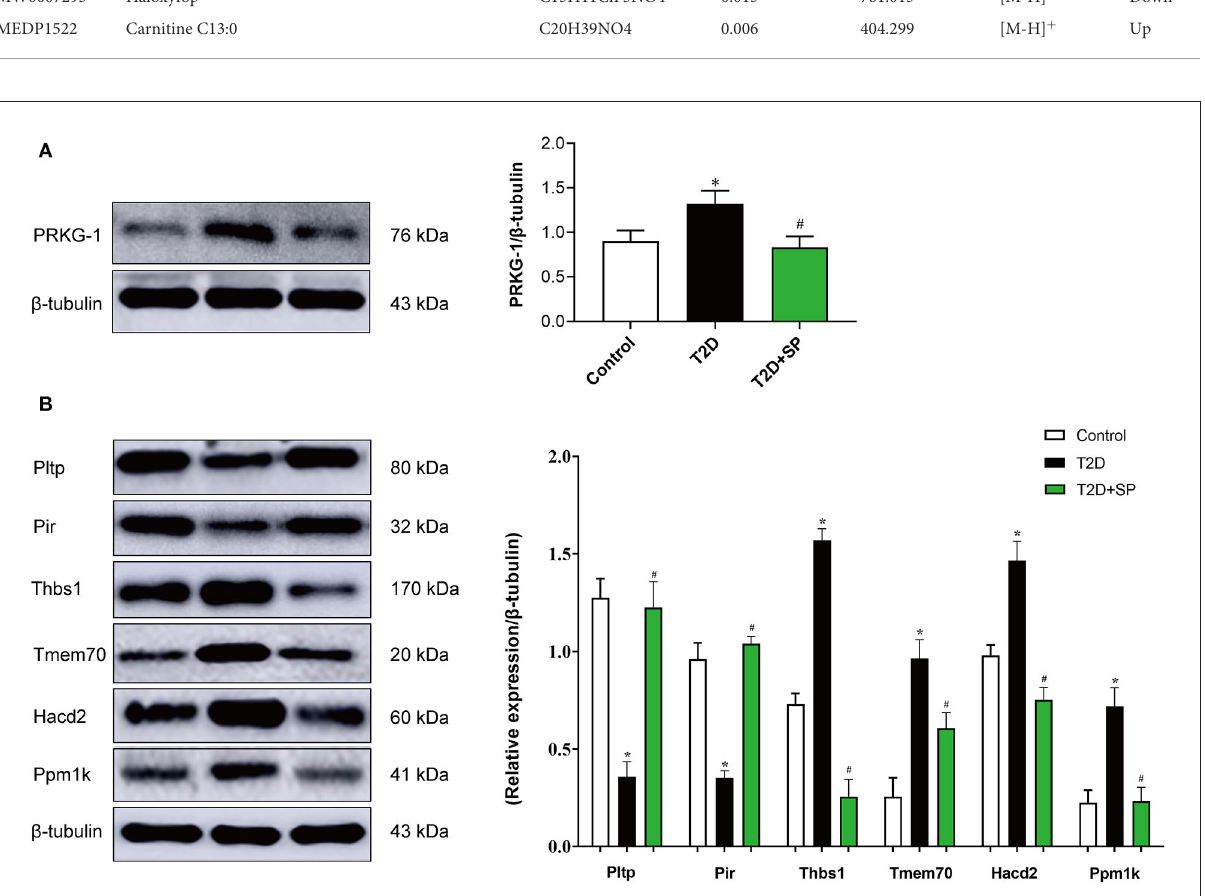
FIGURE7 Western blot analysis of the DEPs between the db/db and SP-treated mice. (A) The protein expression level of PRKG1 was determined by the Western blot. (B) The protein expression levels of Pltp, Pir, Thbs1, Tmem70, Hacd2, and Ppm1k were detected by Western blot. * P < 0.05 vs. Control group; # P < 0.05 vs . T2D group ( n =